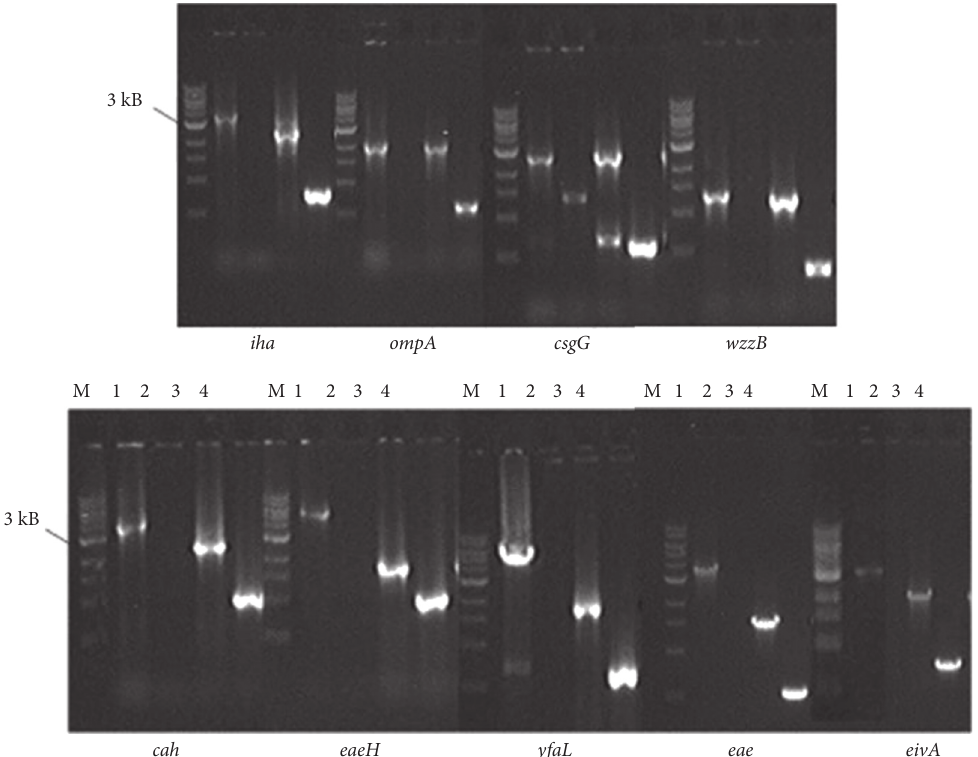
Figure 3: Gel electrophoretic confirmation of deletions. Above is an agarose gel picture of colony PCR products obtained after single-step inactivation of each gene. Each lane marked is as follows: M-1 kb marker (ladder), 1&2 SS17 parental strain with primers A&B and A&C, respectively, and 3&4 SS17 deletion mutants with primers A&B and A&C, respectively. Primers indicated are the primers in Table S3. Primers A&B are specific to the gene indicated under each gel image and primer C is the matching reverse primer specific to the Kan cassette that is partnered with each gene’s primer